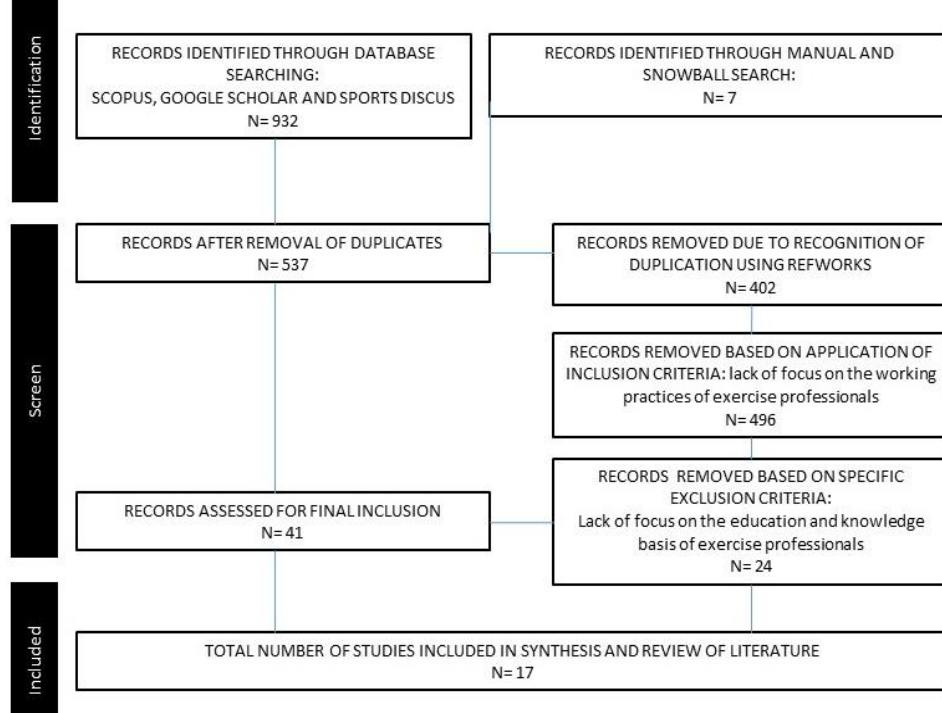
Figure 1. Schematic diagram of systematic process of literature review.